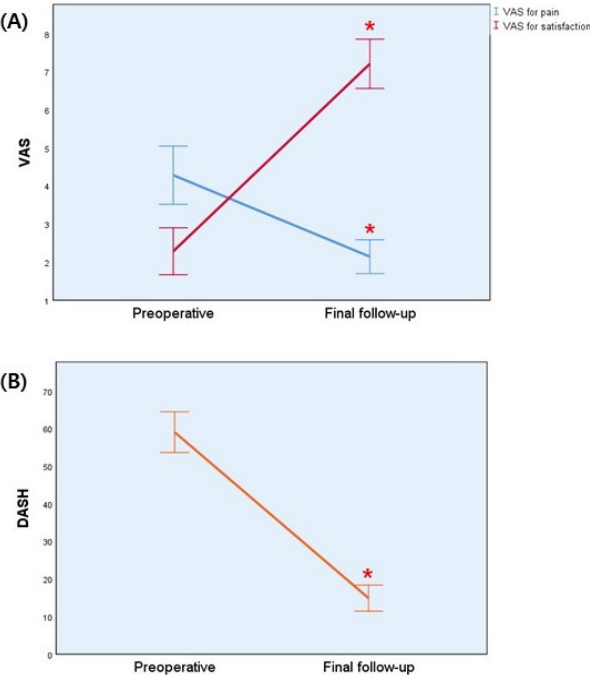
Figure 2. Graph showing functional outcomes at preoperative and final follow-up period; ( A ) VAS scores for pain (blue) and satisfaction (red) ( B ) DASH score (yellow). * p < 0.05. Error bars represent 95% confidence intervals. VAS: visual analog scale; DASH: Disabilities of Arm, Shoulder and Hand. All patients had complete bone union at the final follow-up (Figure 3). The mean duration of bone union was 9.2 ( ± 2.5) weeks (range, 7–16 weeks). One patient had delayed union, with 16 weeks of bone